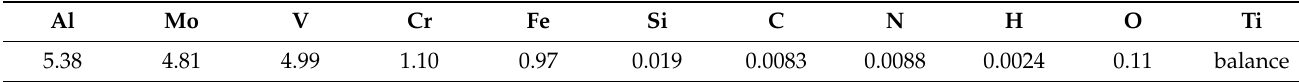
Figure 7. Morphology of the WC-12Co powder. Table 6. Chemical composition of WC-12Co and the TC18 substrate wt.%.